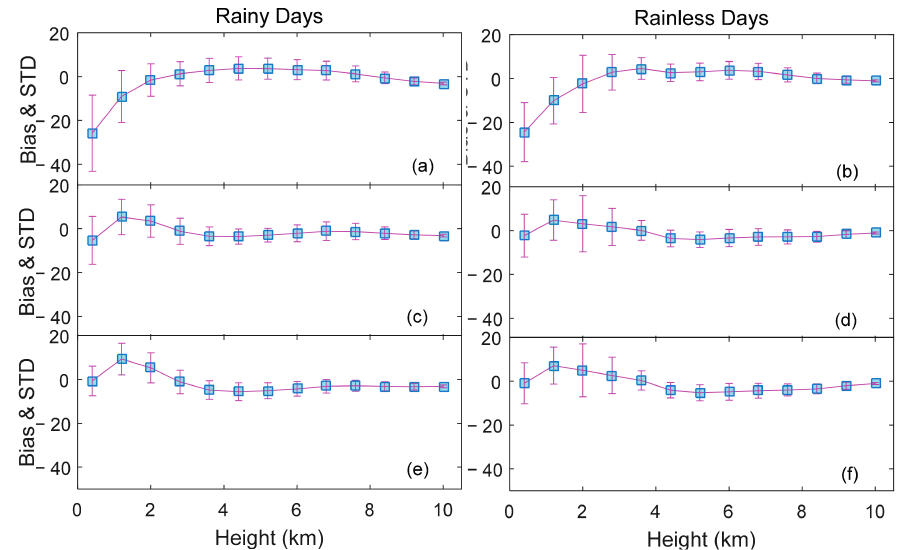
Figure 7. Layered bias and STD calculated from the comparison between tomography results and ECMWF results during rainy days (20 July to 26 July) and rainless days (1 August to 7 August) in 2015. The light blue squares indicate bias and the error bars indicate STD. ( a , b ): a priori information free strategy; ( c , d ): one radiosonde observation constrained strategy; ( e , f ): GNSS meteorological data constrained